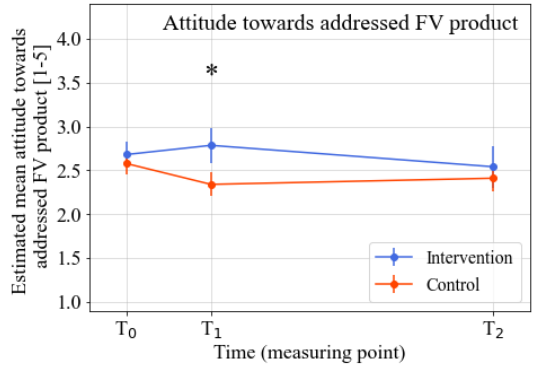
Figure 3. Estimated marginal means of taste preferences from T0–T2. Note. Time span: T1–T0 = three weeks; T2–T0 = three months. * Significant difference between the intervention and control group ( p ≤ 0.05). Analyzed by linear mixed model analyses. All analyses were corrected for baseline outcome, sex, age, FV product assessed in the questionnaire, and the baseline scores of the other four determinants of FV intake.